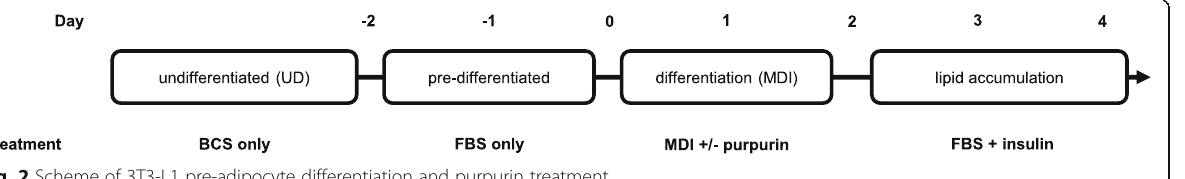
Fig. 2 Scheme of 3T3-L1 pre-adipocyte differentiation and purpurin treatment